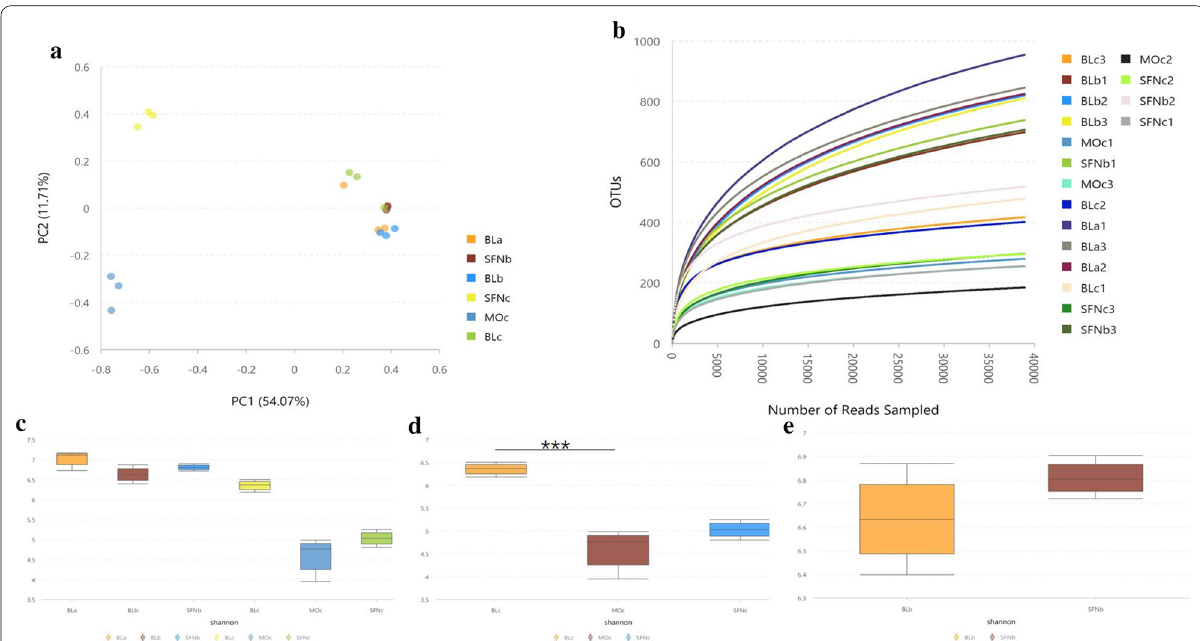
Fig. 3 Sulforaphane (SFN) modulated the structure and diversity of gut microbiota. a Principal coordinate analysis (PCoA) and b Alpha diversity analysis at the OTU level of mouse’s fecal microbiota. c – e Shannon index in different group. Significant differences between blank vs. DSS are indicated: ***P < 0.001. Bl represents the blank group, SFN represents the SFN group, MO represents the DSS group. a represents day 0 of the group, b represents day 7 of the group, c represents day 14 of the group. As Moc represents the day 14 of the DSS